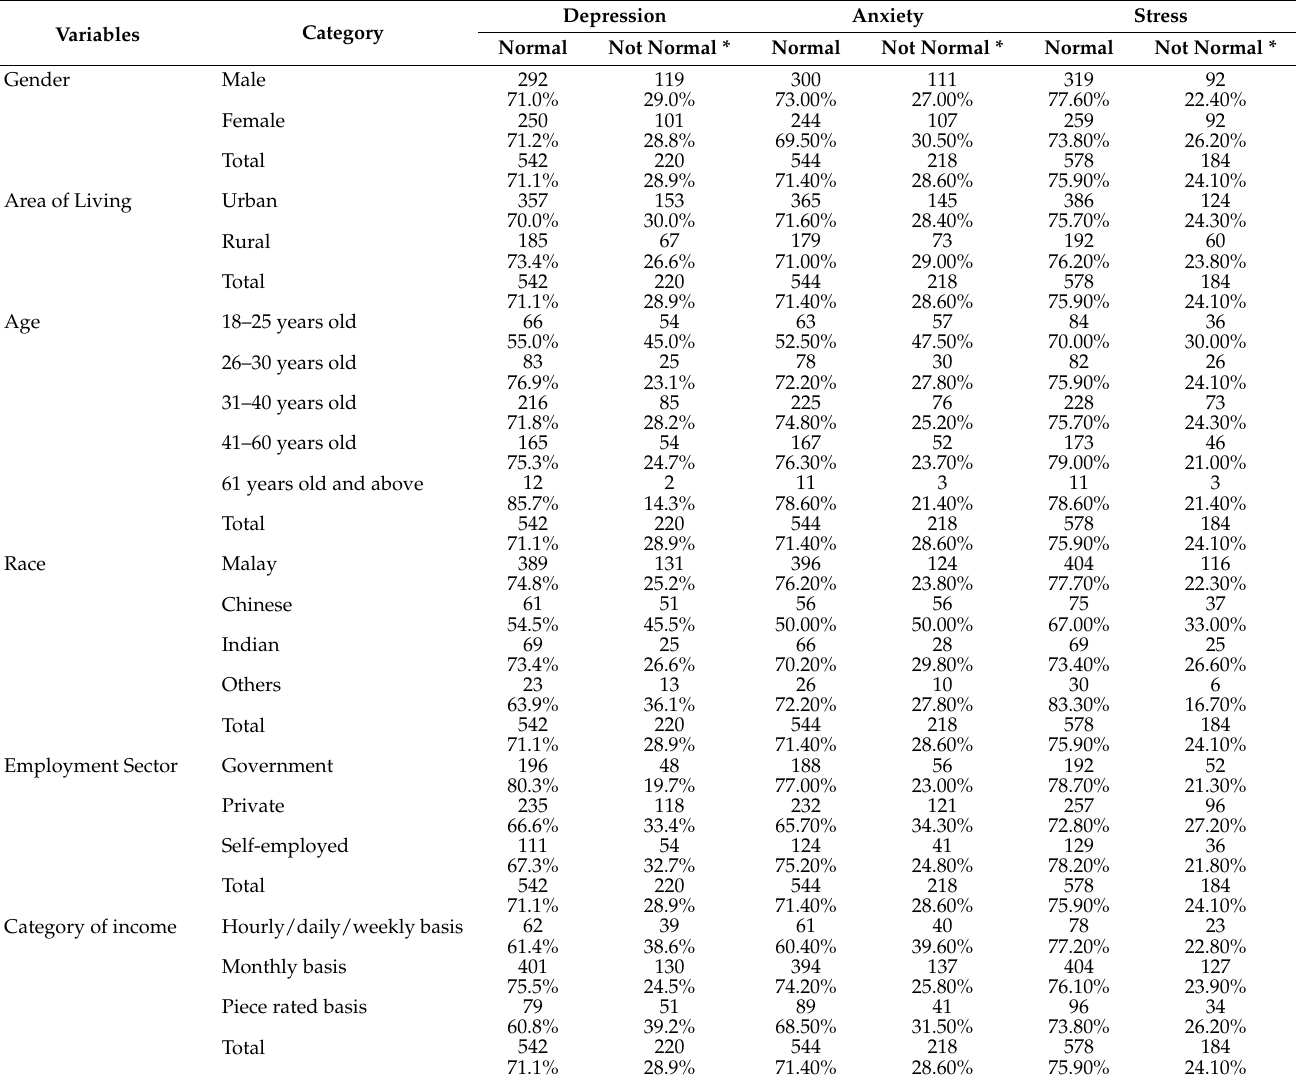
Table 3. Rate and Percentage of Depression, Anxiety, and Stress Levels for demographic factors 1